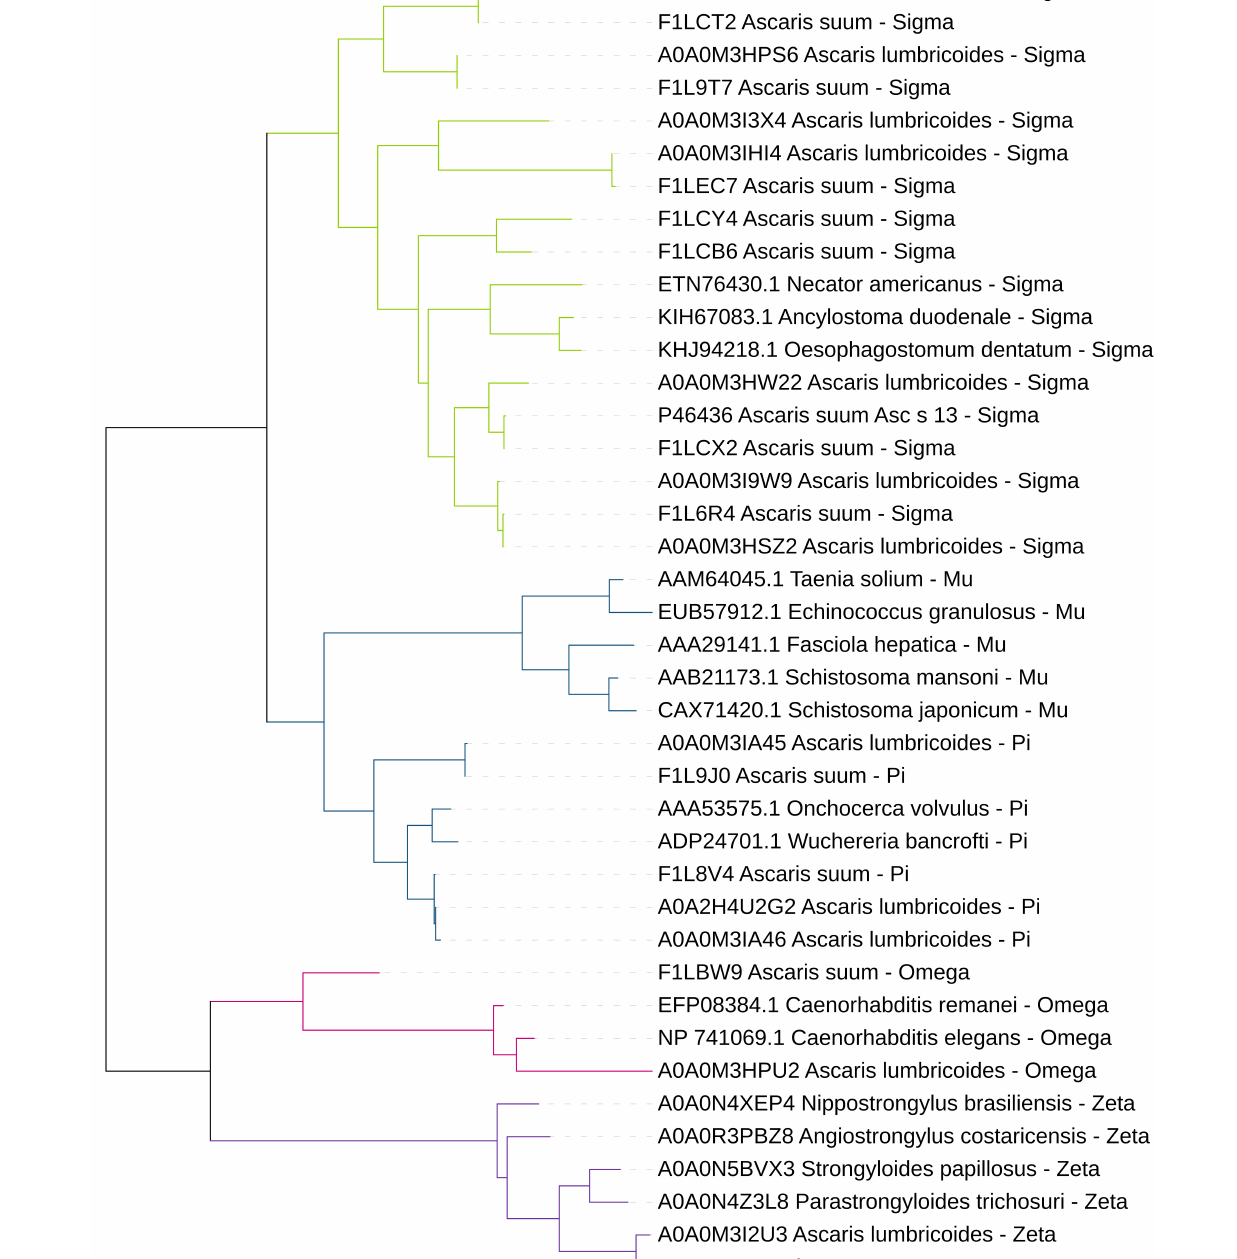
a safe product and showed a promising effect on reducing disease severity